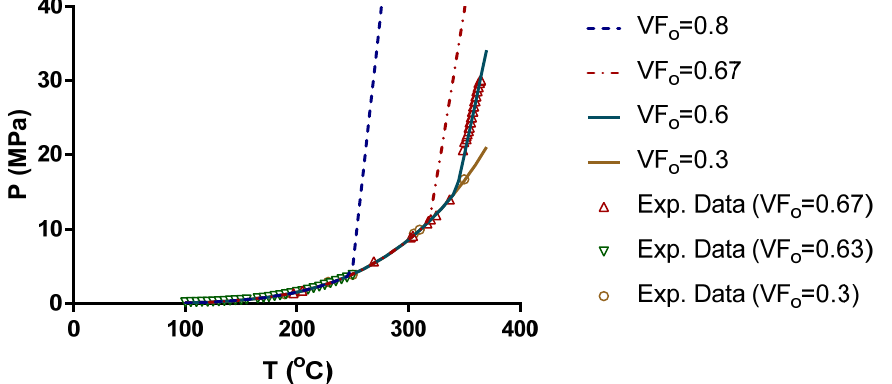
Figure 3. Comparison of measured and estimated reactor pressure at different initial liquid water volume fractions ( VF o ).